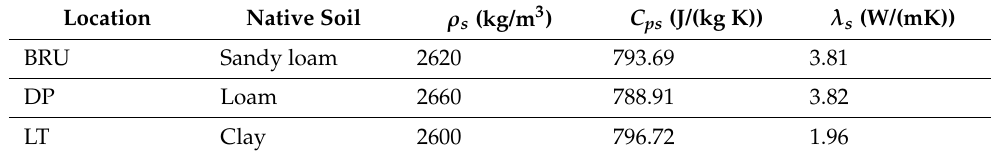
Table 5. Density and solid thermal properties of native soils (adopted from [47]). Location Native